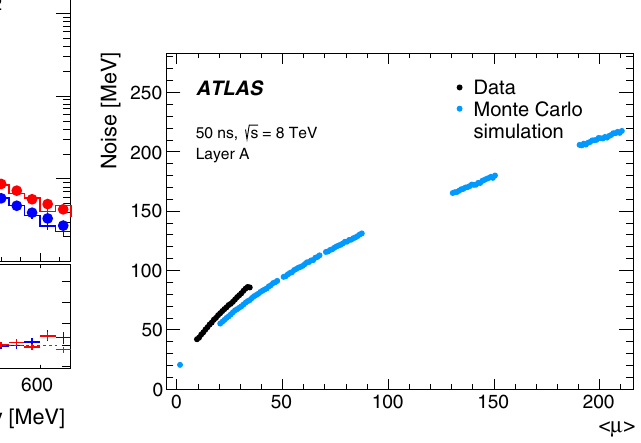
Fig. 12 The area-normalised energy spectra in cells A12 over all Tile- Cal modules for two different pile-up conditions (cid:4) μ (cid:5) = 20 , 30 (left) and the total noise, computed as the standard deviation of the energy